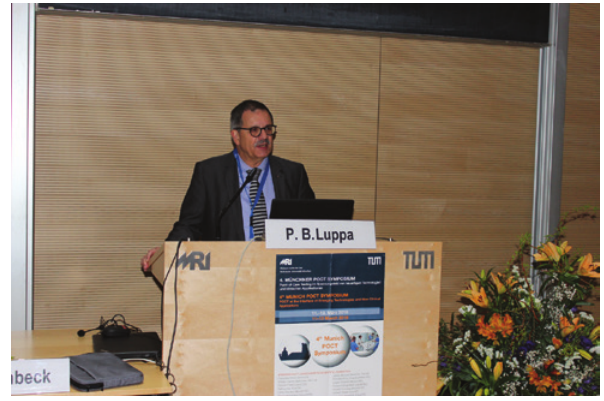
Figure 2: Peter B. Luppa during his opening speech.